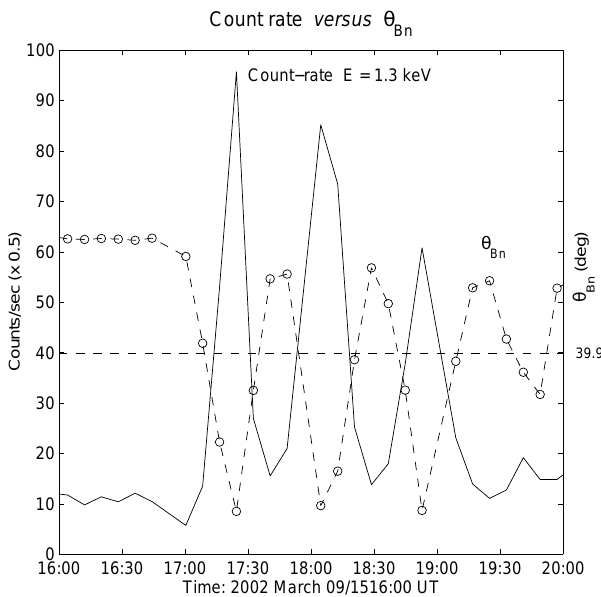
Fig. 5. The changes in local shock θ B n angle (dashed line-open circles) and the particle count rates during the interval when the ULF waves are present. The dashed horizontal line corresponds to = 39 . 9 ◦ . For clarity, the particle count rate values have been θ c B n scaled by a factor